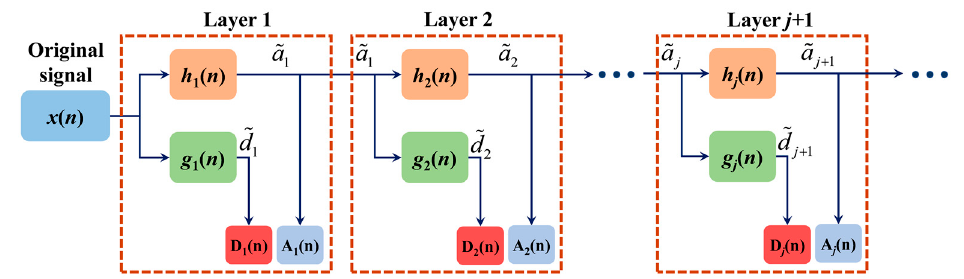
Figure 3. Schematic of the decomposition signal obtained by SWT.